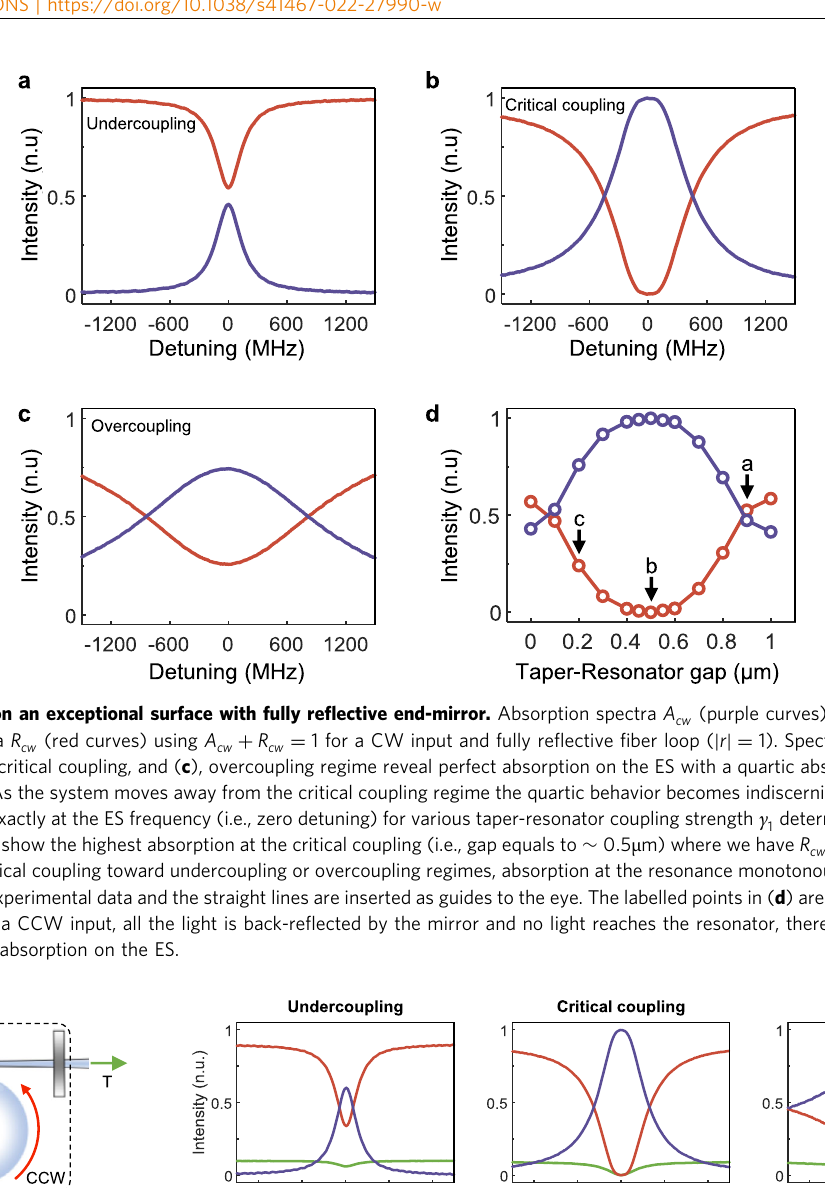
determined by the gap between 1